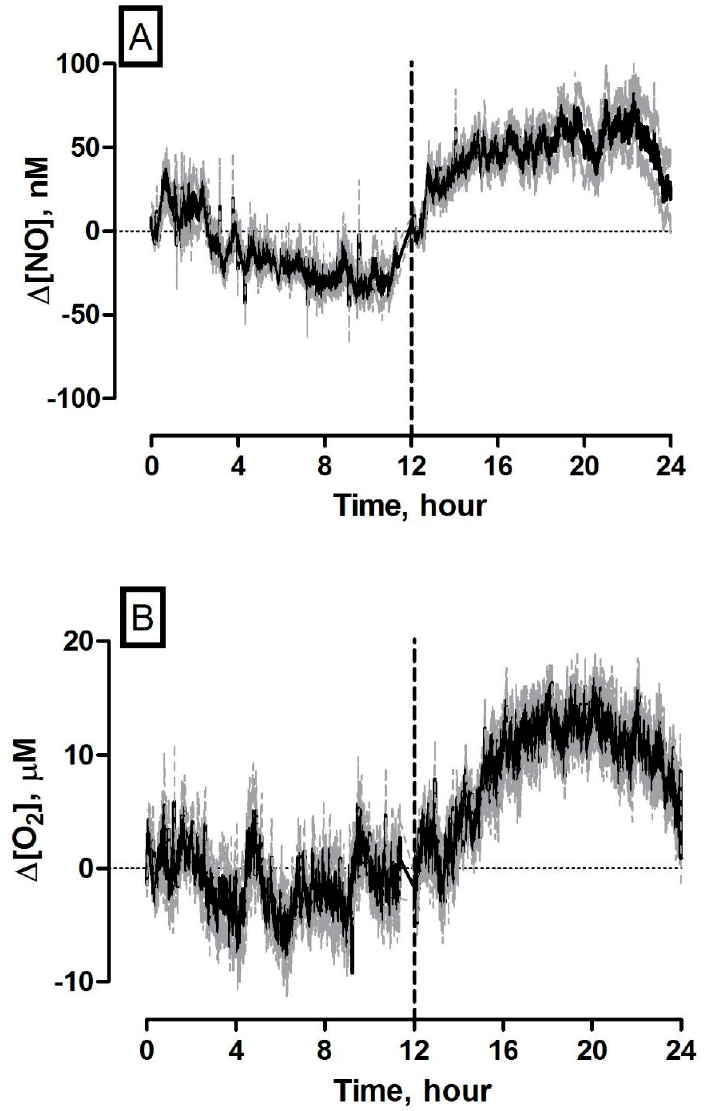
Figure 6. Averaged 24 h concentration dynamics measured using ( A ) NO and ( B ) O 2 sensors implanted in the striatum of NOD SCID mice. Mean concentration represented by black trace, error represented by grey trace. 0–12 h represent light phase (07.00–19.00) and 12–24 h represent dark phase (19.00–07.00). Vertical dashed line signifies end of light phase/start of dark phase.